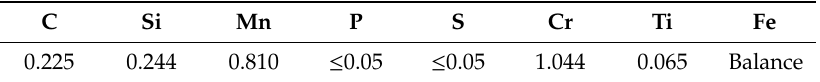
Table 1. Typical chemical compositions of substrate (wt. %).